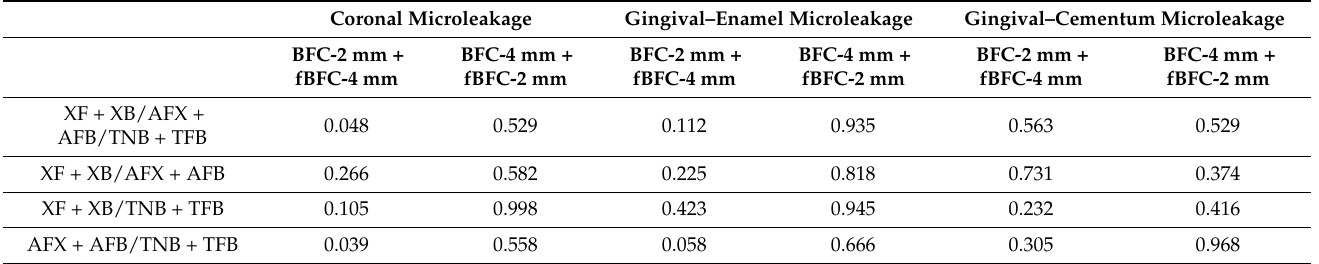
Table 3. Comparison of microleakage values in groups in which flowable composites were applied in 2 mm and 4 mm